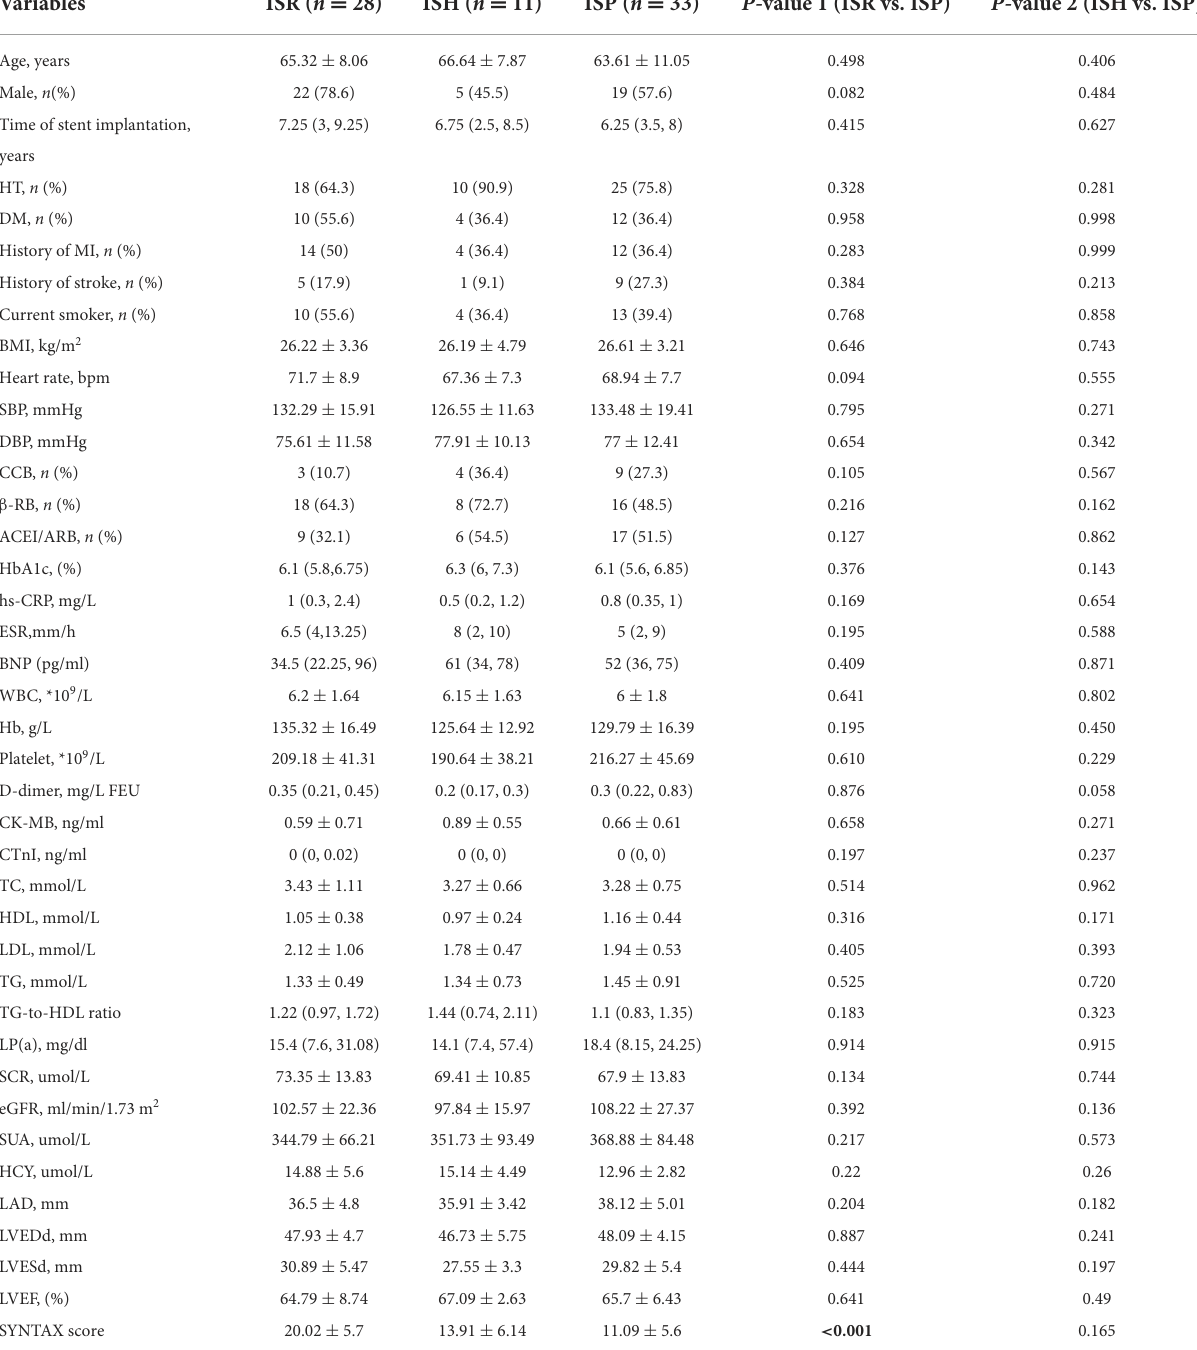
TABLE 1 Baseline characteristics of the study